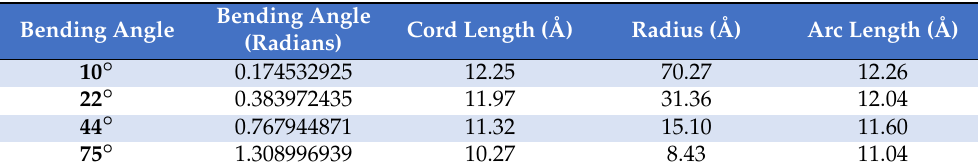
Table 1. Obtained cord length, radius, and arc length for proposed bending curvatures. Bending